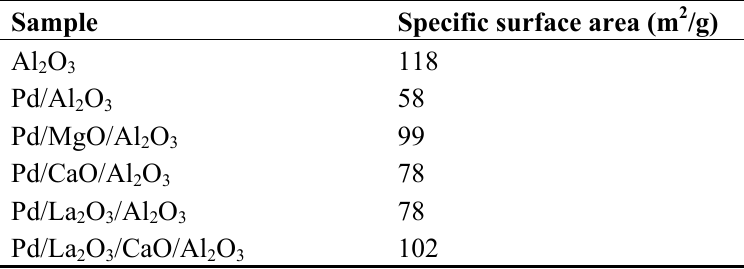
O egg-shell catalyst in POM reaction at 2 3